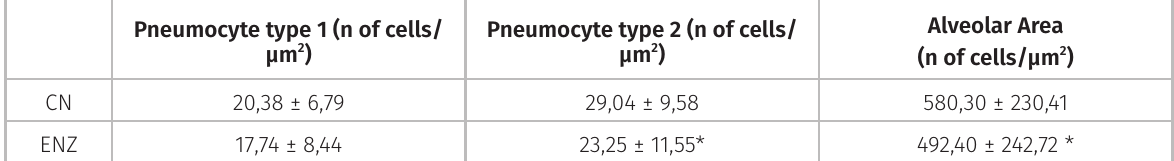
Table I. Number of type and type 2 pneumocytes in the lungs of mice treated with the fibrinolytic enzyme produced by Mucor subtilissimus UCP 1262 (2000mg/mL). The results are expressed as mean ± SD. Statistical differences were determined by the Mann-Whitney U-test. CN: negative control; ENZ: fibrinolytic enzyme produced by Mucor subtilissimus. * P <0.05 vs